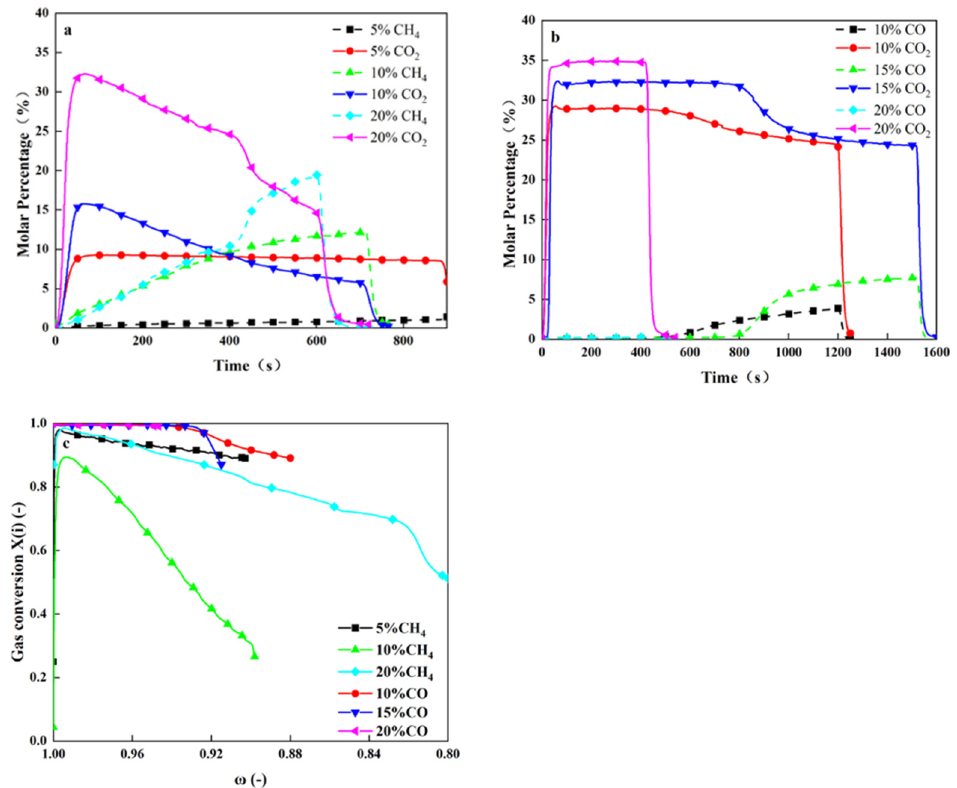
Figure 10. Effect of gas concentration on the combustion performance with CH 4 and CO, comparing ( a ) CH 4 and CO 2 concentration curves in CH 4 experiments, ( b ) CO and CO 2 concentration curves in CO experiments, and ( c ) gas conversion at three concentrations in CH 4 and CO experiments.